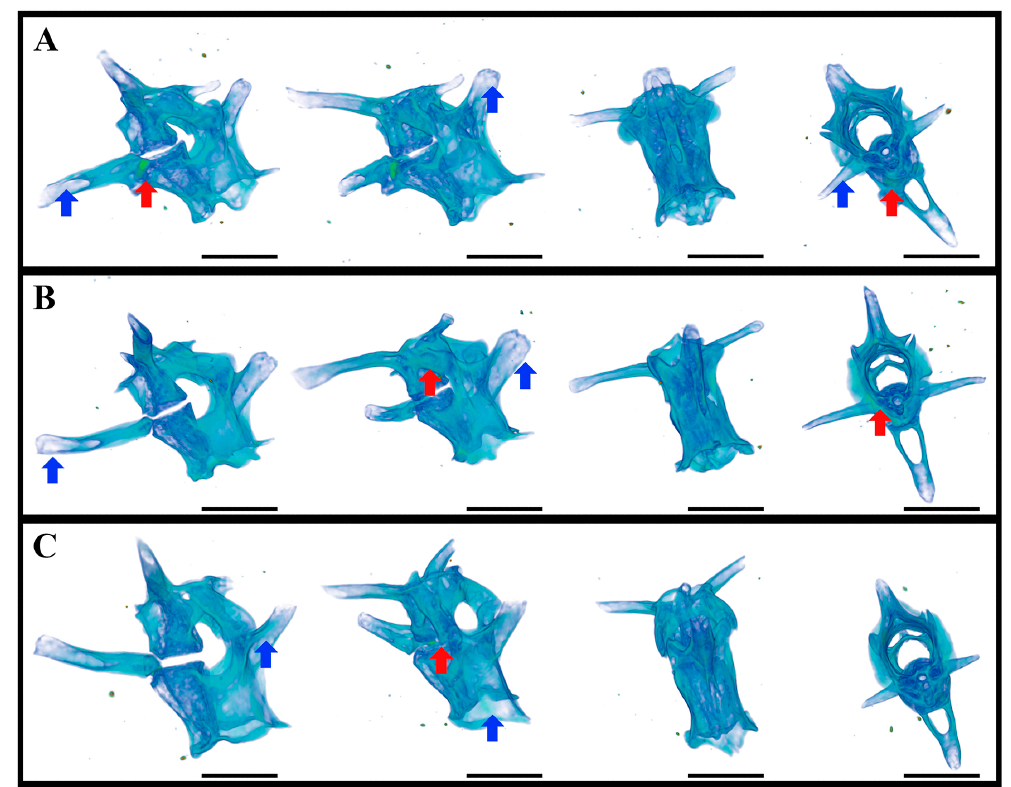
Figure 4. X-ray μ CT of the thick-toed gecko proximal vertebrae bone results (Bion-M1). ( А ) terrarium control group gecko. ( B ) Delayed synchronous control group gecko. ( C ) Flight group gecko. Extracellular matrix alterations are well seen in the high-density areas (green colored, red arrows). Extracellular matrix density in the low dense areas (blue colored, blue arrows) remains unchanged. These results show that the high dense bone areas are the starting points of the demineralization process. Bar: ( A,B,C ) 1 mm.